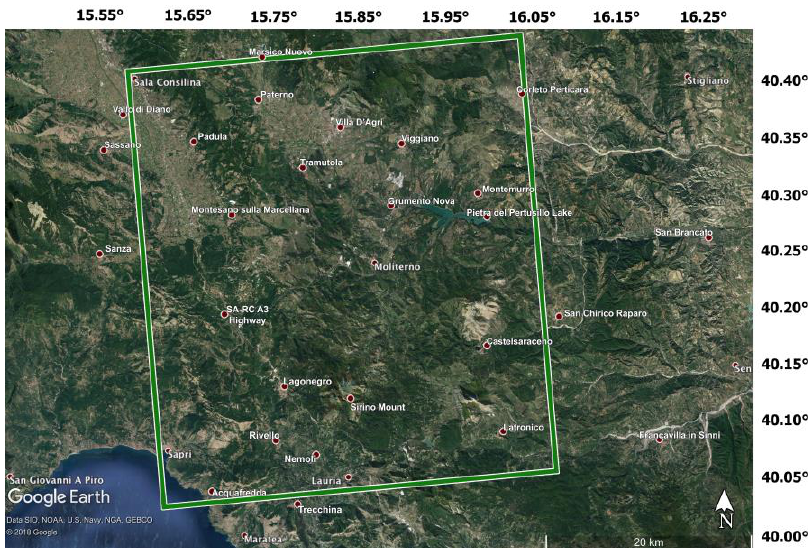
Figure 8. Optical image of the study area, covered by the COSMO-SkyMed acquisitions used for the tests. The footprint of the processed CSK frame is highlighted by a green rectangle. The Google Earth optical images have been acquired by the Landsat satellites on 14 December 2015. Table 1. The Used COSMO-SkyMed Dataset.